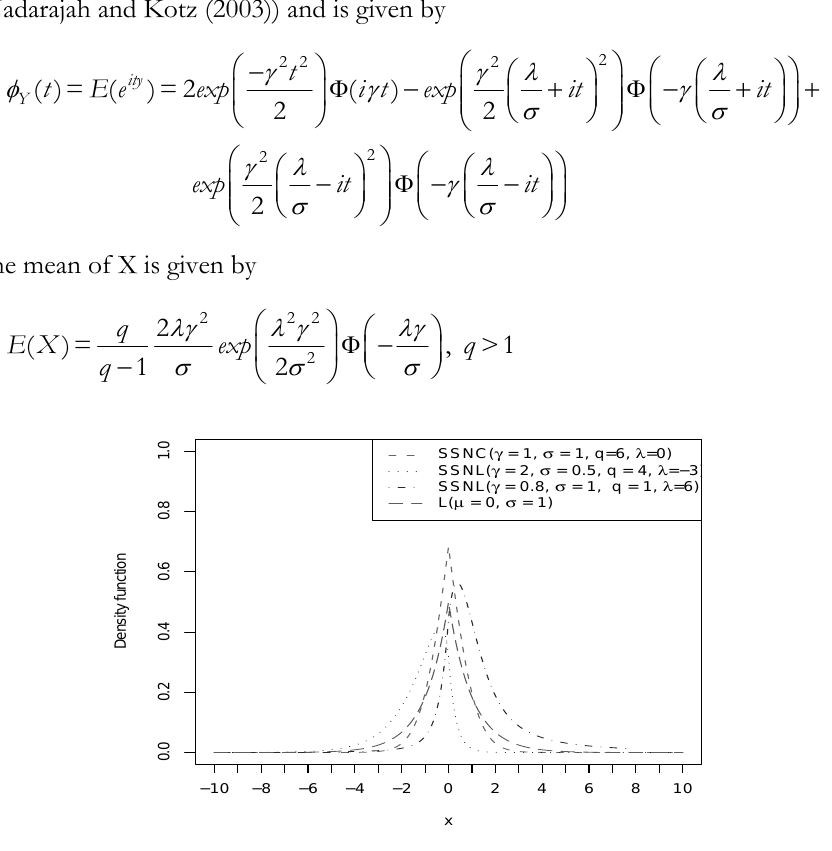
Figure 3 – Skew slash normal-Laplace density functions for various values of